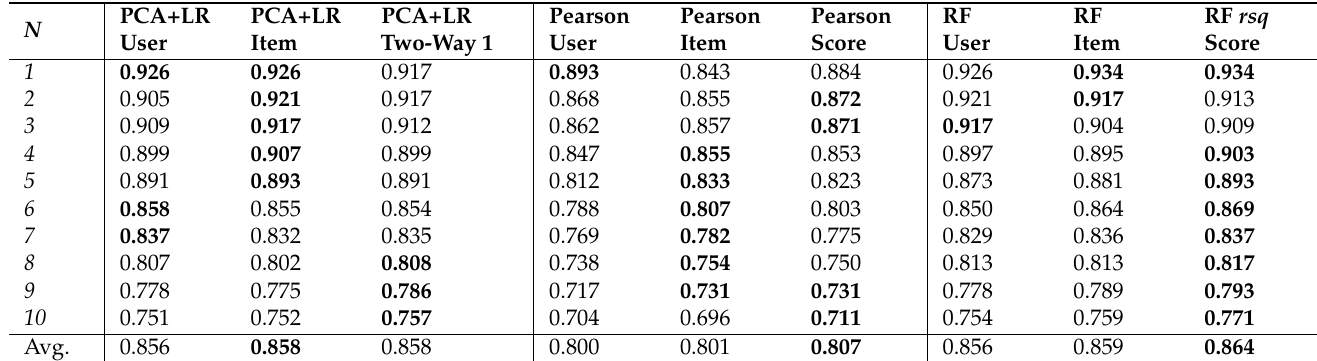
Table 3. Top- N accuracy for case 1.